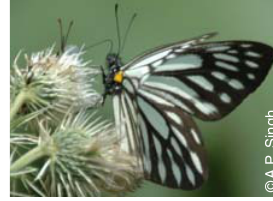
Image 120. Small Grass Yellow, Eurema brigitta (under)